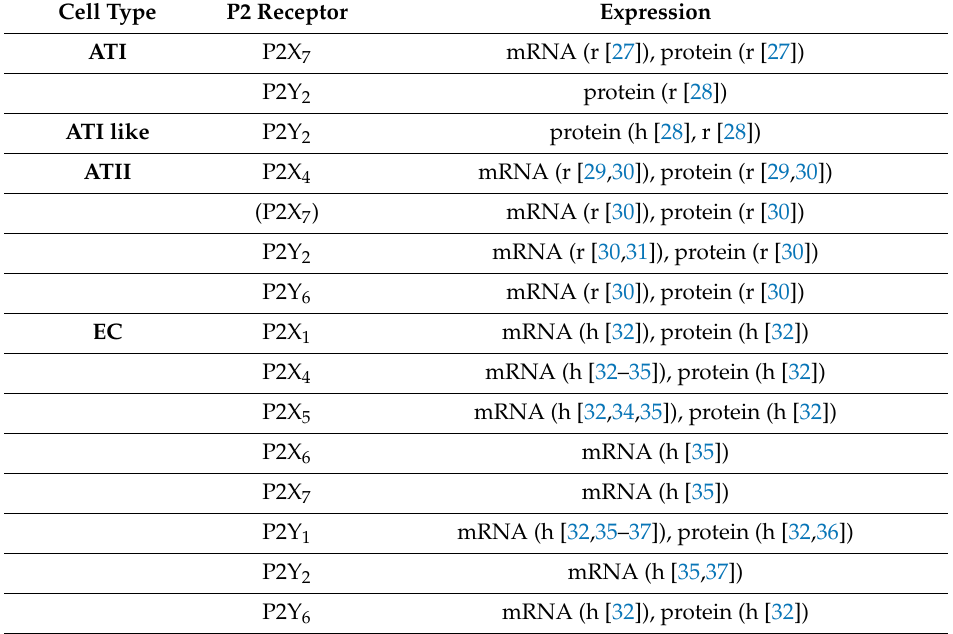
Table 1. Expression of P2 receptors within the cells of the distal